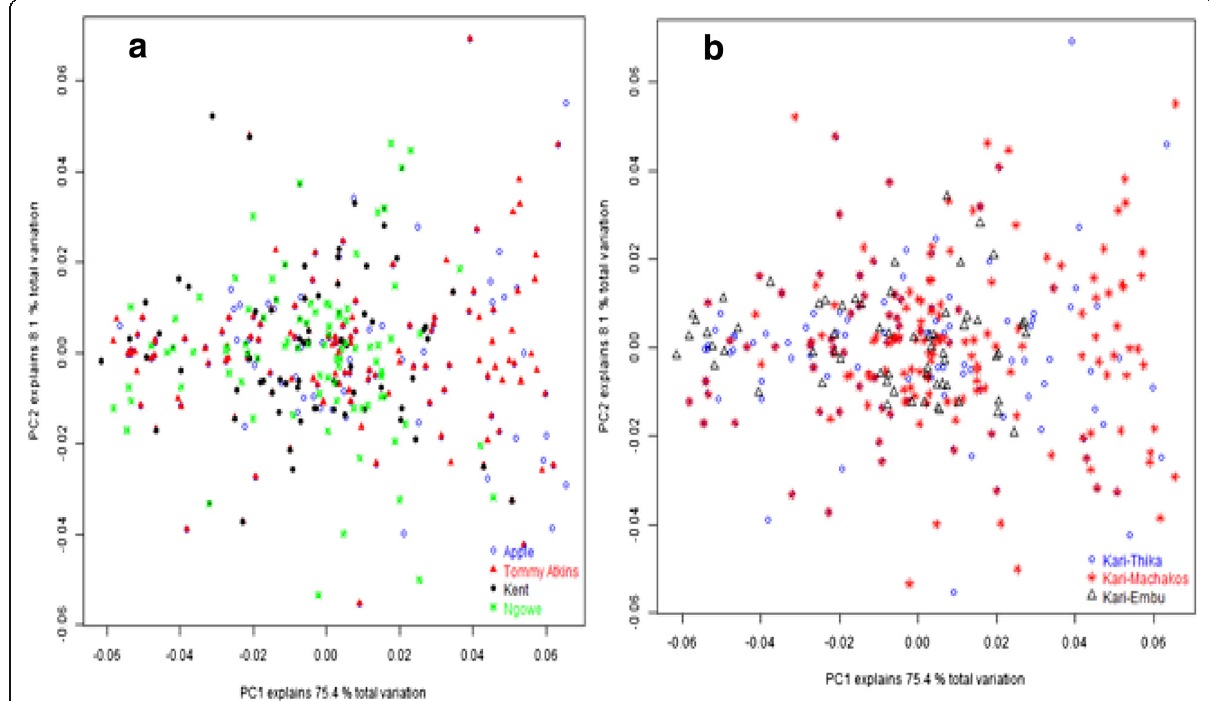
Fig. 4 Comparisons of mean fructose and glucose contents of Apple, Tommy Atkins, Ngowe, and Kent mango cultivars across KARI-Thika, KARI- Machakos, and KARI-Embu locations. Values represent mean ± Std. dev. Different letters denote significant differences ( p < 0.05); values bearing the same superscript are not significantly different from one another. Number of pulps samples analyzed for Apple in KARI-Thika (20), KARI- Machakos (51), and KARI-Embu (17); Tommy Atkins in KARI-Thika (20), KARI-Machakos (37), and KARI-Embu (12); Ngowe in KARI-Thika (9) and KARI- Machakos (58); Kent in KARI-Thika (8), KARI-Machakos (18), and KARI-Embu (26). Amounts are per 100 g of freeze dry weight, N = number of trees per cultivar in each